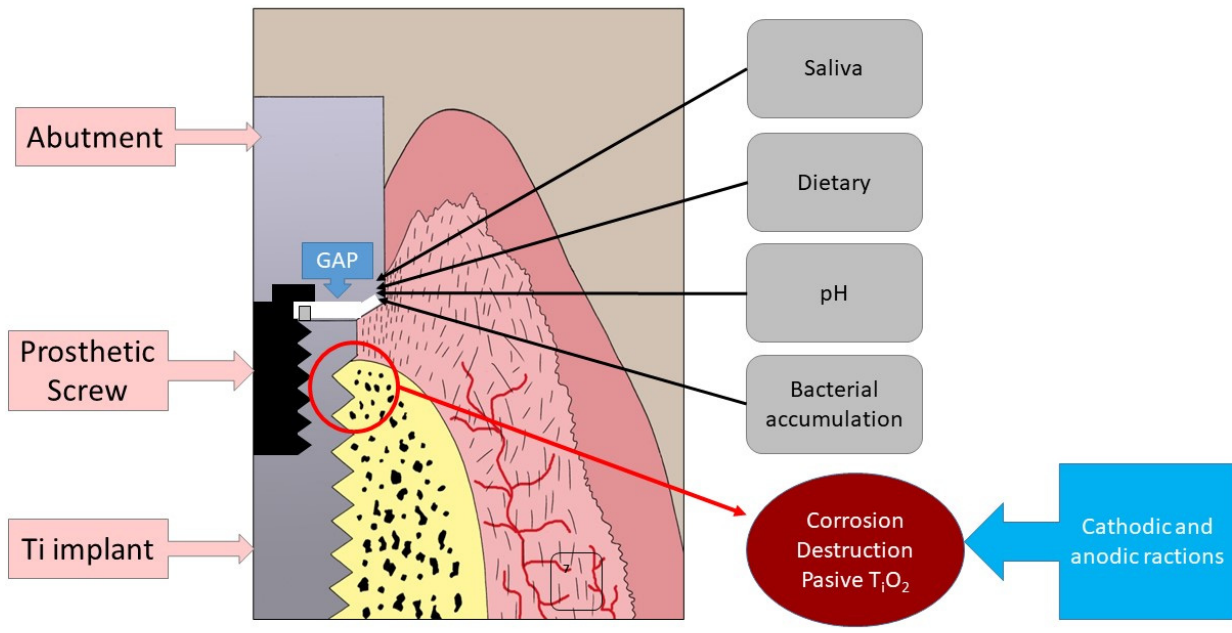
Figure 2. Different ways in which a dental implant can corrode and lose its passivated layer.